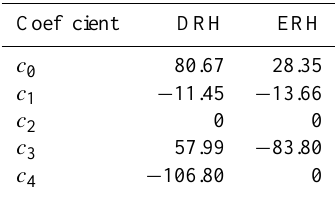
Table 1. Parameterization of DRH( ε ) and ERH( ε ) data sets shown in Fig. 4. Coefficients express equations of the form DRH( ε ) = 6 i c i,d ε i valid for 0 ≤ ε ≤ 0 . 86 and ERH( ε )= 6 i c i,e ε i valid for 0 ≤ ε ≤ 0 . 55. The parameterization of DRH( ε ) is for full deliquescence. These equations for DRH( ε ) and ERH( ε ) appear as the dashed lines in Fig. 4. The parameterization is accurate compared to the data within 1.5%RH for DRH( ε ) and 4% for ERH( ε ).